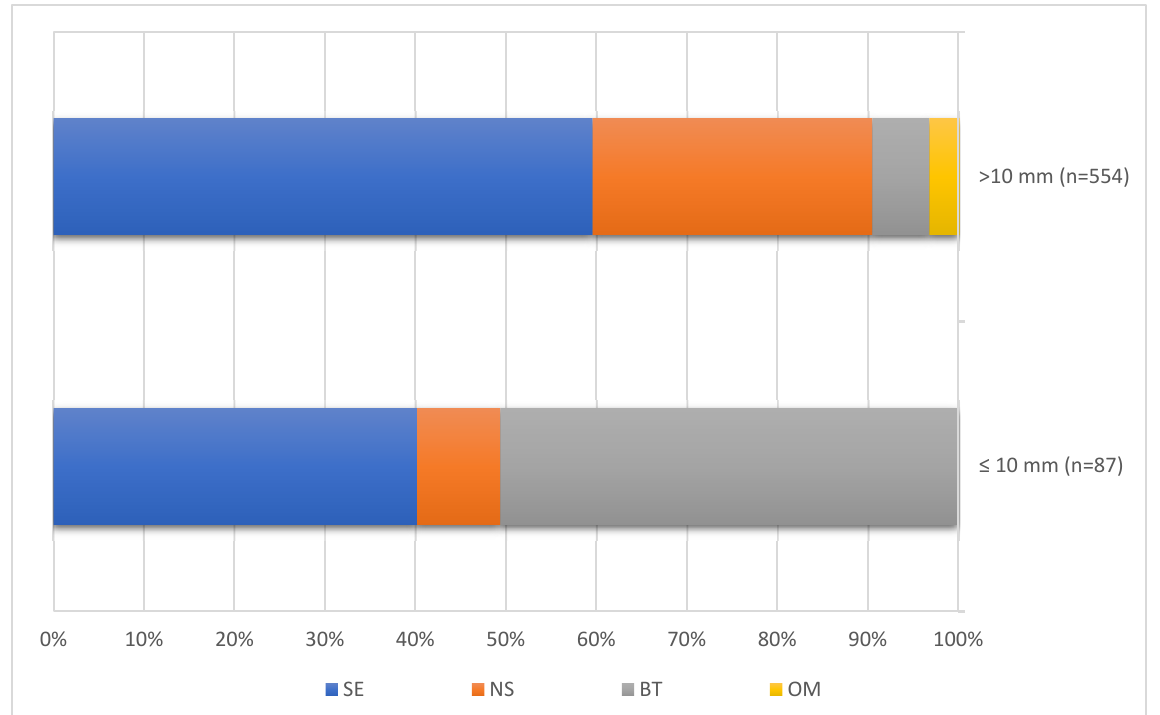
Figure 3. Proportions of histologic subgroups in testicular tumours sized > 10 mm and ≤ 10 mm. Table 5. Frequencies of histologic subgroups in four tumour size categories.